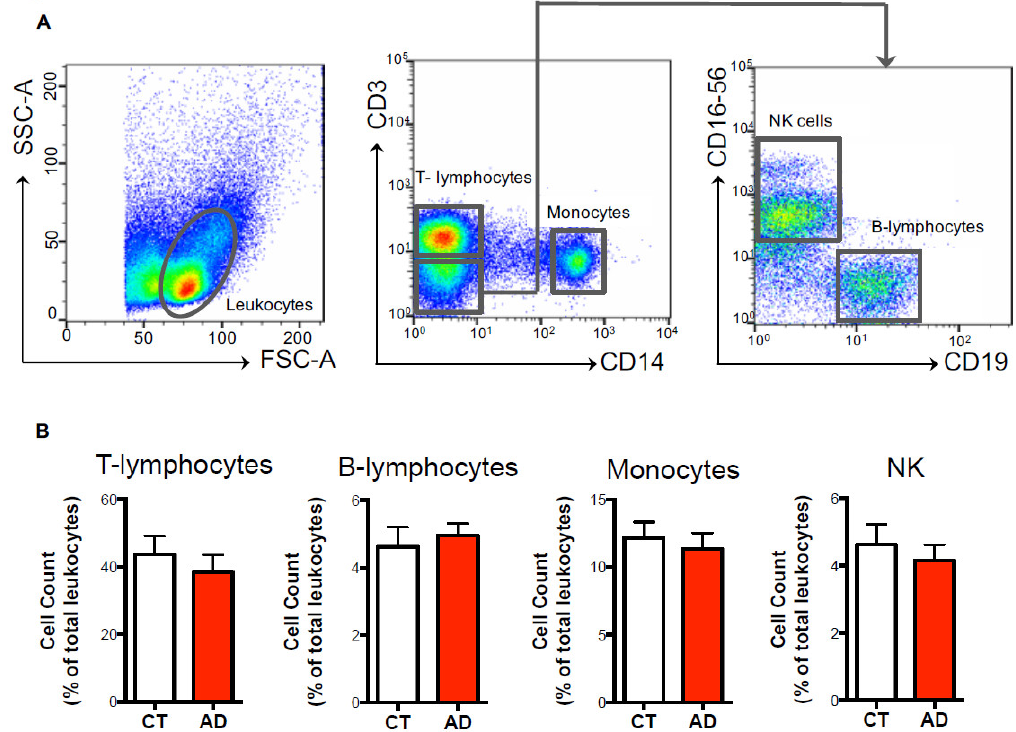
Figure 1. Immunophenotyping of immune cell populations. PMBCs (2–3 × 10 6 ) were stained at the cell surface with specific markers for the main innate and adaptive immune cell populations, and were analyzed through polychromatic flow cy- tometry, as detailed in the materials and methods. ( A ) According to physical parameters, total leukocytes were identified and further gated as CD14+ (monocytes) or CD3+ (T-lymphocytes) upon exclusion of CD3- cells. CD3- cells were subse- quently gated against CD19+ (B-lymphocytes) and CD16+CD56+ (NK cells). ( B ) Histograms of the cell counts (expressed as percentage ± s.e.m. of total leukocytes) of T-lymphocytes, B-lymphocytes, monocytes and NK cells in both healthy controls (CT) and Alzheimer’s disease (AD) subjects.